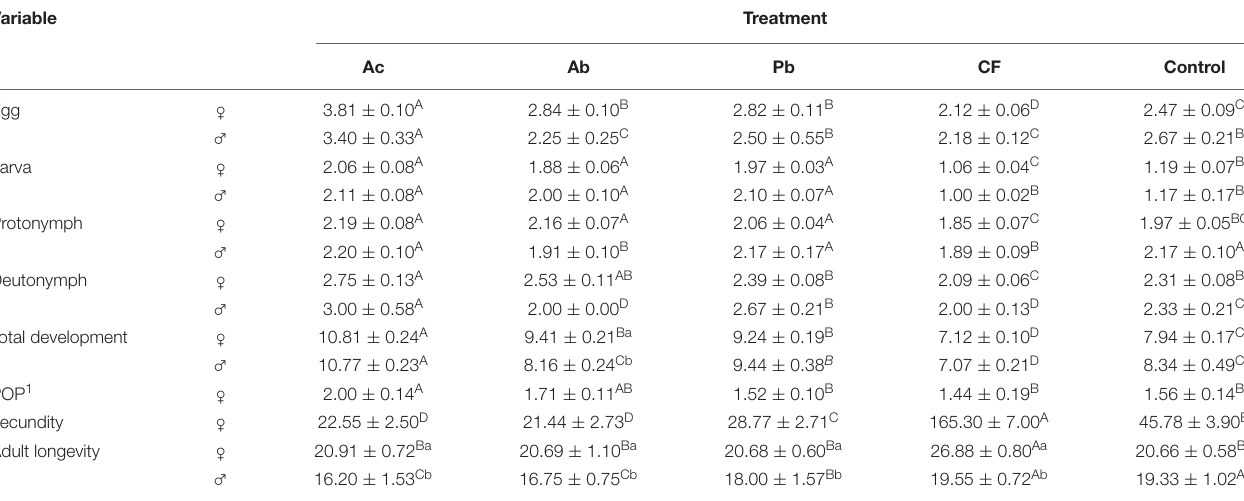
TABLE 1 | Mean ( ± SE) developmental times of life stages and phases (in days) and fecundity (number of eggs/female) of T. urticae calculated using the age-stage, two-sex life table.